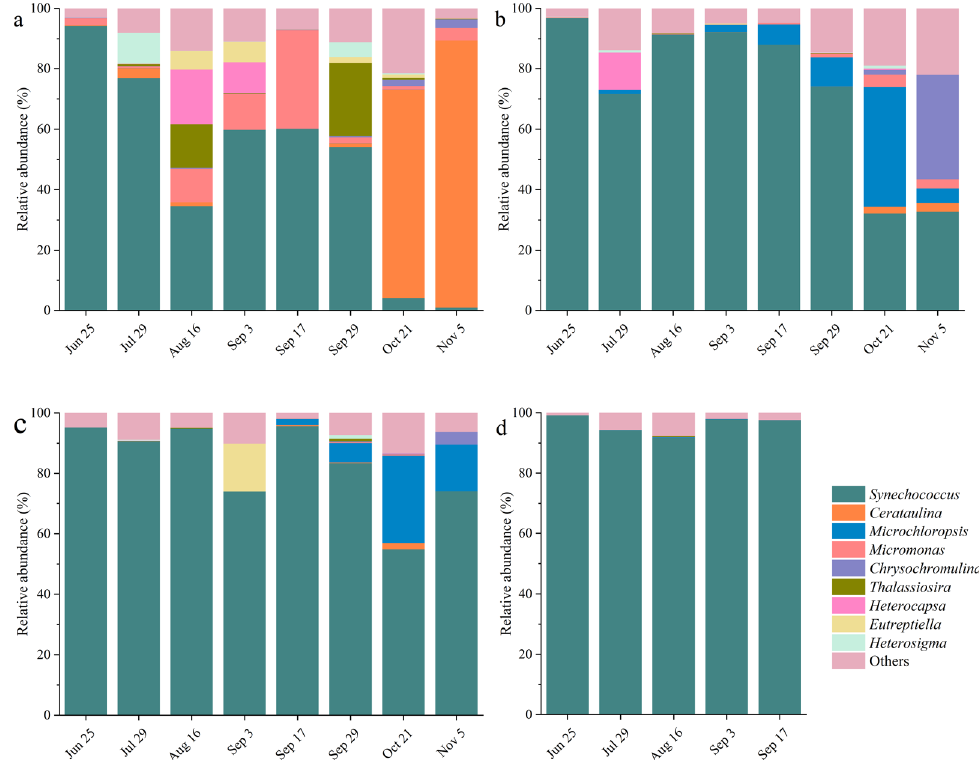
Figure 5. Temporal variation in the relative abundance of phytoplankton genera in the aquaculture water ( a ) and hepatopancreas samples of M. mercenaria ( b ), M. meretrix ( c ), and R. philippinarum ( d ) were identified with high-throughput